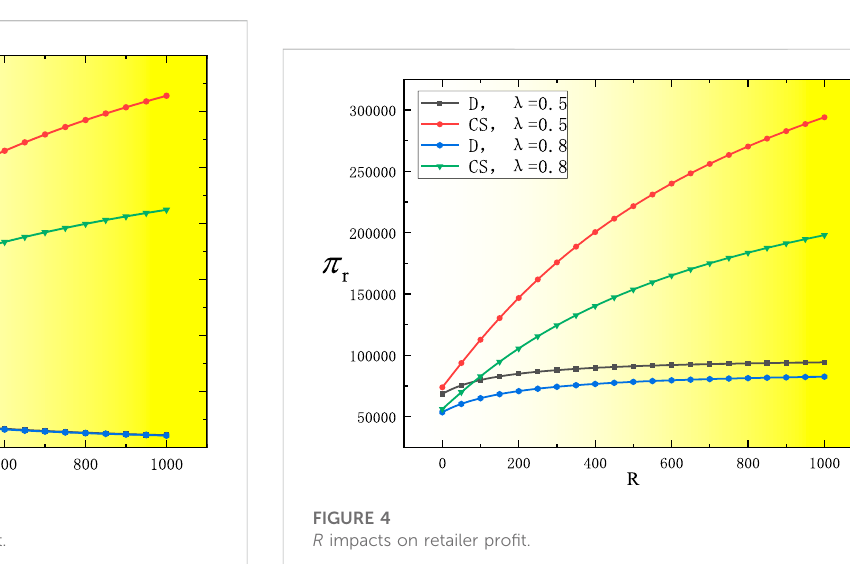
FIGURE 3 R impacts on retail price.